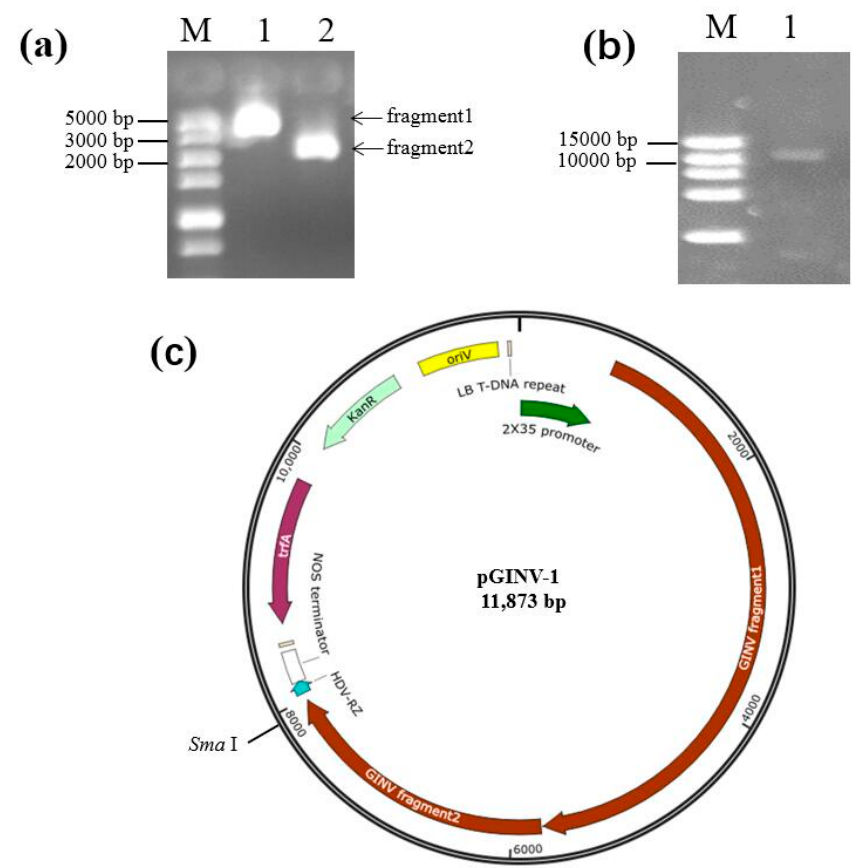
Figure 1. Construction of full-length cDNA clones of grapevine berry inner necrosis virus